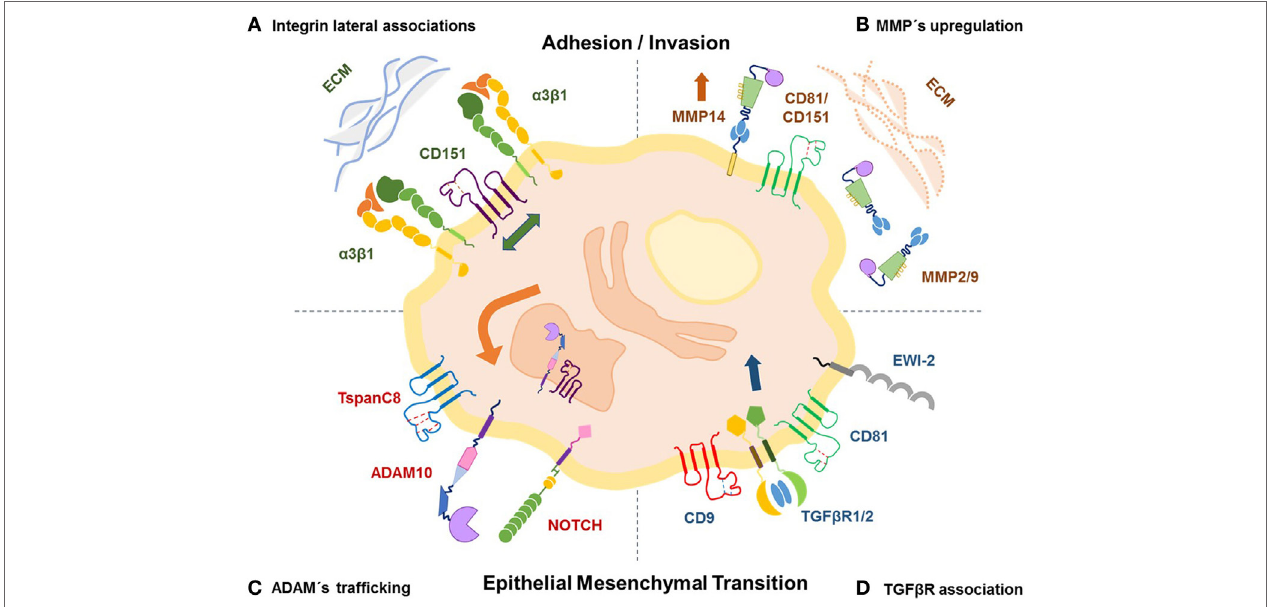
FiGURe 1 | Tetraspanins modulate invasion and metastases by regulating the activity of their partners. (A) Tetraspanins form stable lateral association with integrins in tetraspanin-enriched microdomains (TEMS) favoring spreading, cell adhesion, and migration through the extracellular matrix (ECM); on the other hand, (B) tetraspanins regulate ECM degradation during cell invasion by modulating expression and activity of metalloproteases, such as MMP-2, MMP-9, and MMP-14. (C) The TspanC8 subgroup is known to promote trafficking and cell localization of ADAM10 and its sheddase activity thereby regulating substrates, such as NOTCH receptor, to favor epithelial to mesenchymal transition (EMT). (D) Association of CD9/CD81 with EWI-2 affects TGF β signaling modulating EMT, invasion, and metastases of